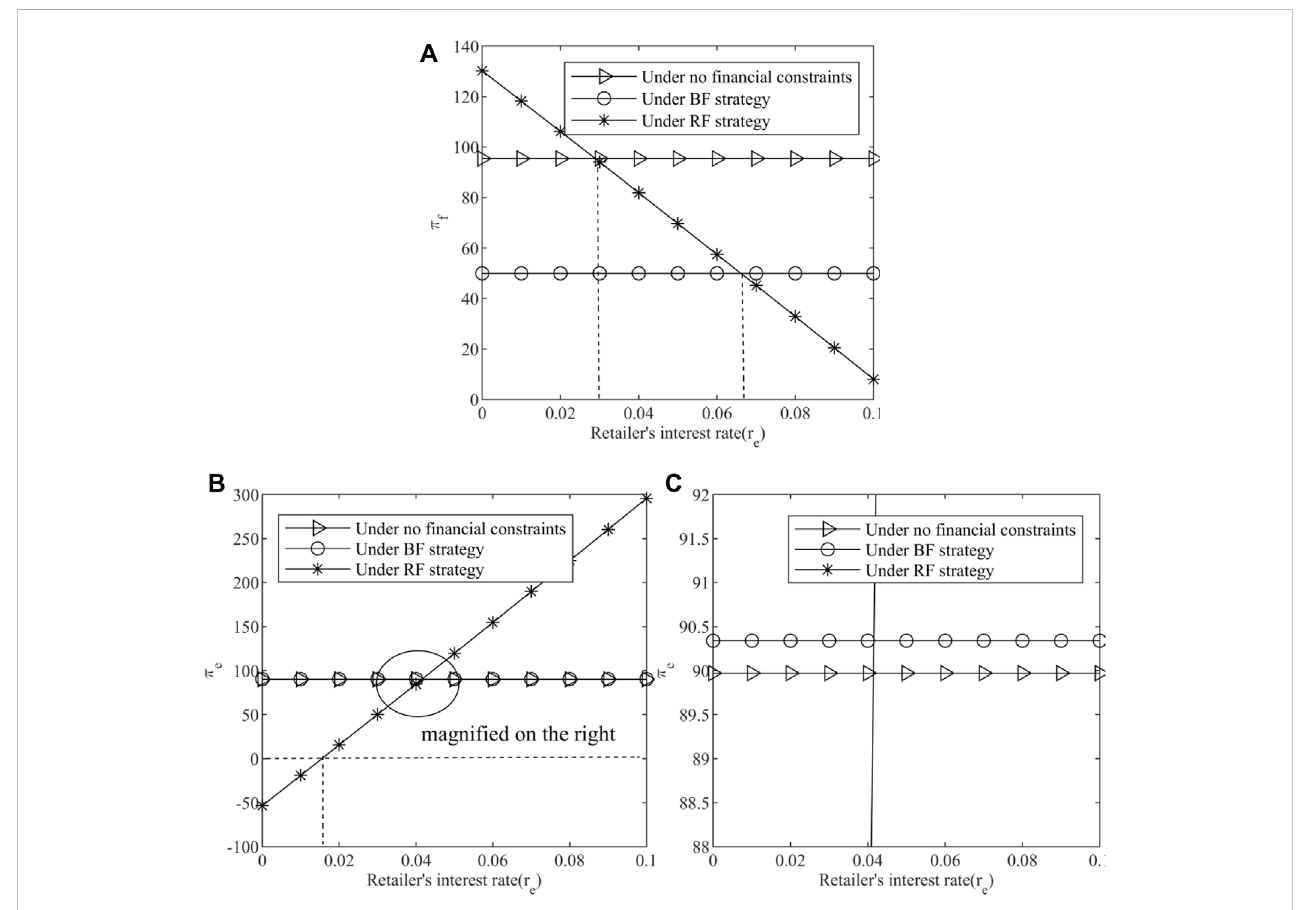
FIGURE 5 (A) Impact of retailer ’ s interest rate on supplier ’ s pro fi t (B,C) Impact of retailer ’ s interest rate on retailer ’ s pro fi